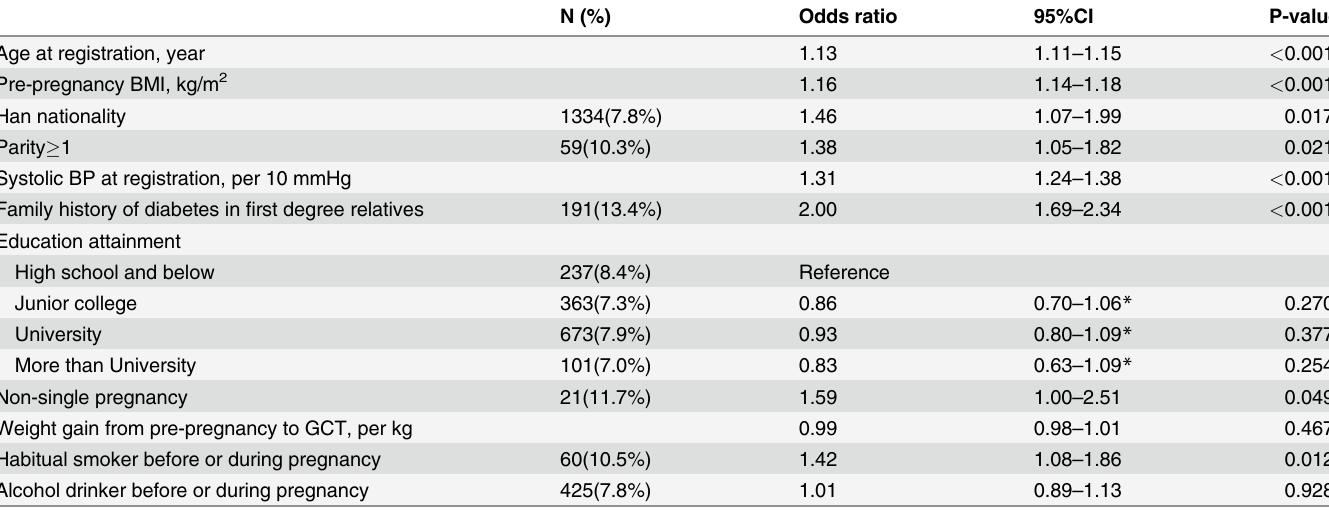
Table 3. Univariable odds ratios of potential risk factors for gestational diabetes mellitus diagnosed by the IADPSG criteria.